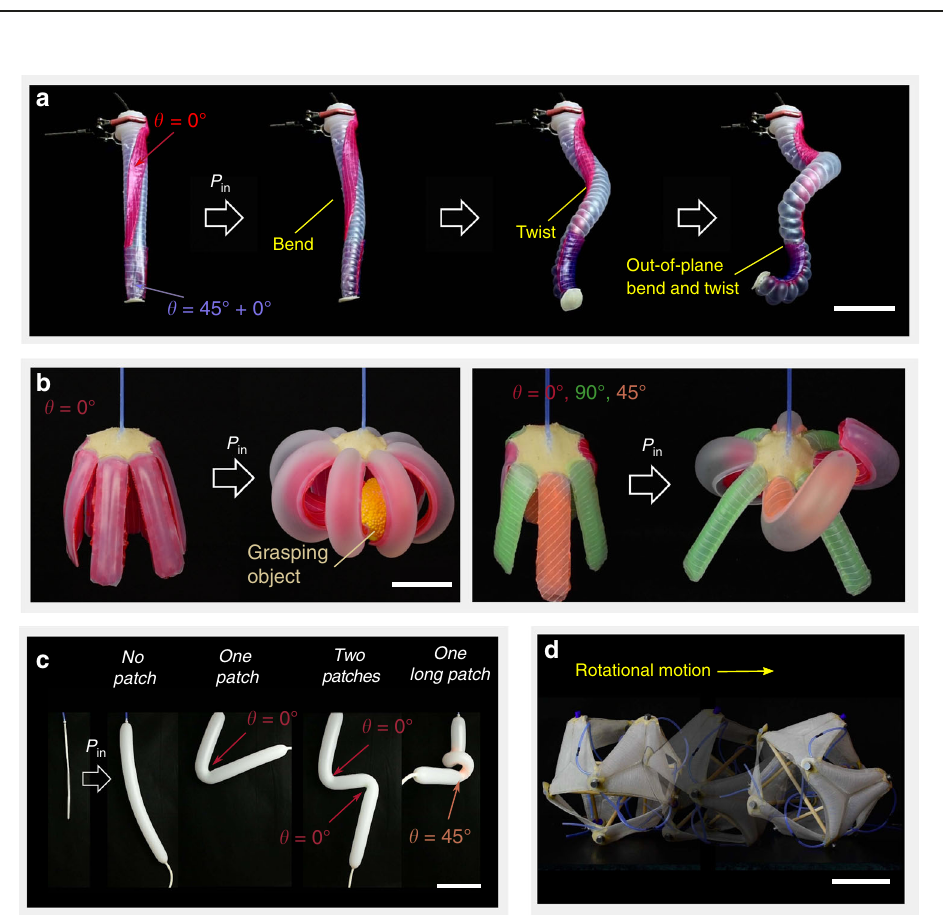
Fig. 4 Practical use cases for STAUD-prepreg controlling compliant systems. a Life-like complex grasping motion akin to cephalopod tentacles accomplished by a cylindrical actuator. Scale bar: 100 mm. b Planar soft body with eight tentacles for use as a pop-up gripper. Adhering STAUD-prepreg patches gives rise to speci fi c movements of individual tentacles that previously in fl ated without directional bias. Scale bar: 50 mm. c Conventional balloon with adhered STAUD-prepreg patches. The fi ber orientation and dimension of the applied patches determine the in fl ation trajectories of the balloon. Scale bar: 50 mm. d A tensegrity robot consisting of rigid struts and soft membrane actuators made from STAUD-prepreg. A combination of rigid components and soft, planar actuators allows this hybrid system to roll from face to face by in fl ating the membrane actuators to locally destabilize itself. Scale bar: 200